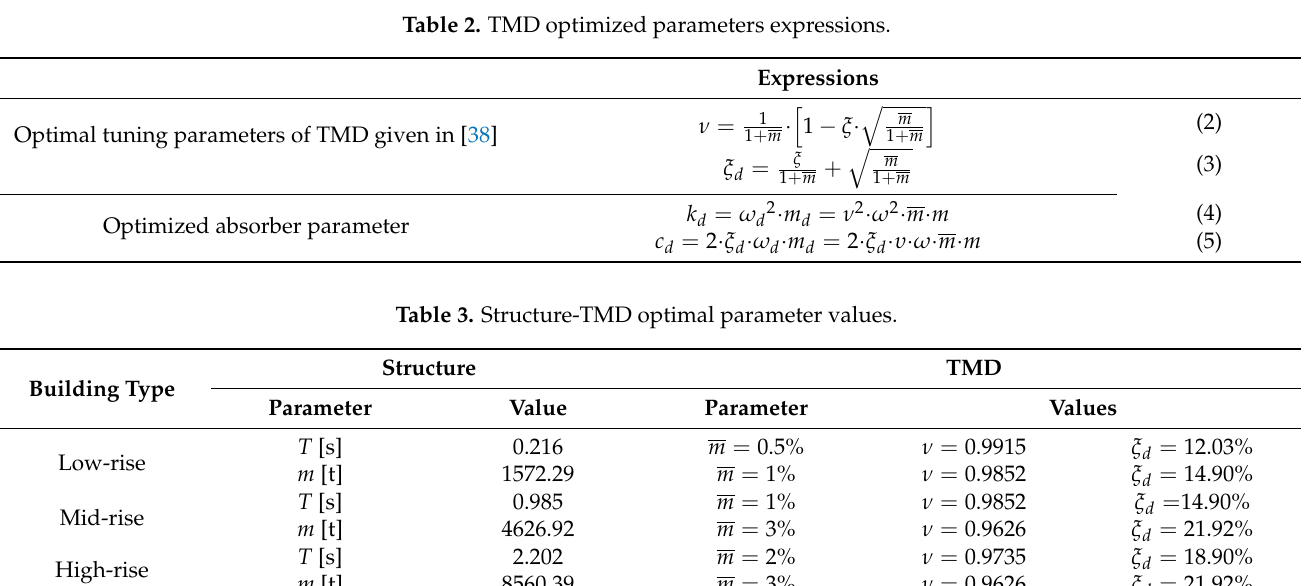
Figure 5. PTMD schematic representation.